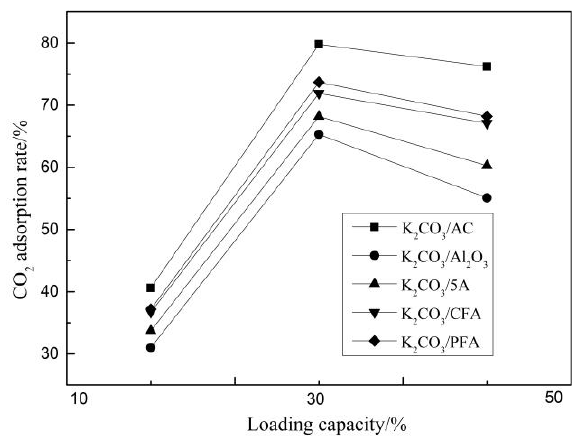
Figure 2. CO 2 adsorption rate at different loading capacities.